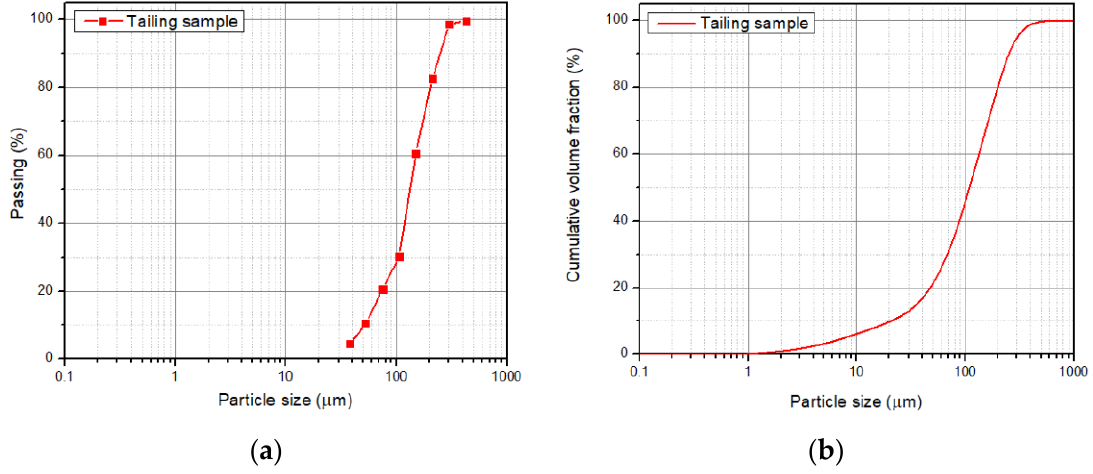
Figure 3. Granulometry of the tailing sample using ( a ) sieving and ( b ) Laser Diffraction.